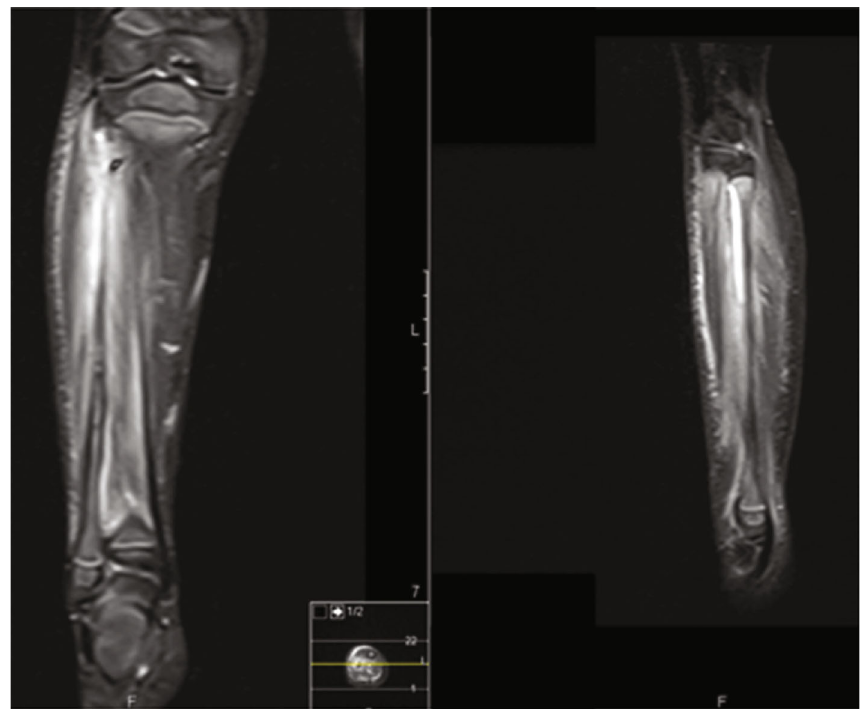
Figure 1: MRI (T1 STIR) of the left leg showing abscess involving the adjacent muscle and